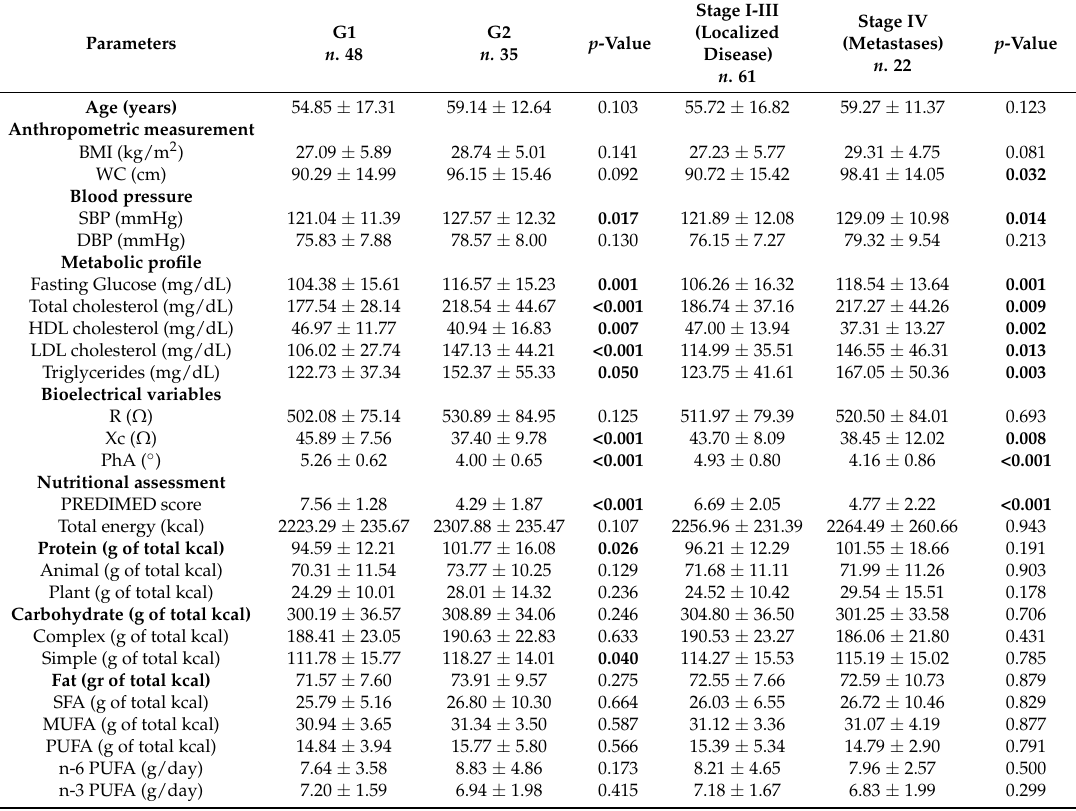
Table 3. Demographic, clinical, metabolic, and bioelectrical parameters in the GEP-NET patients according to tumor grading and